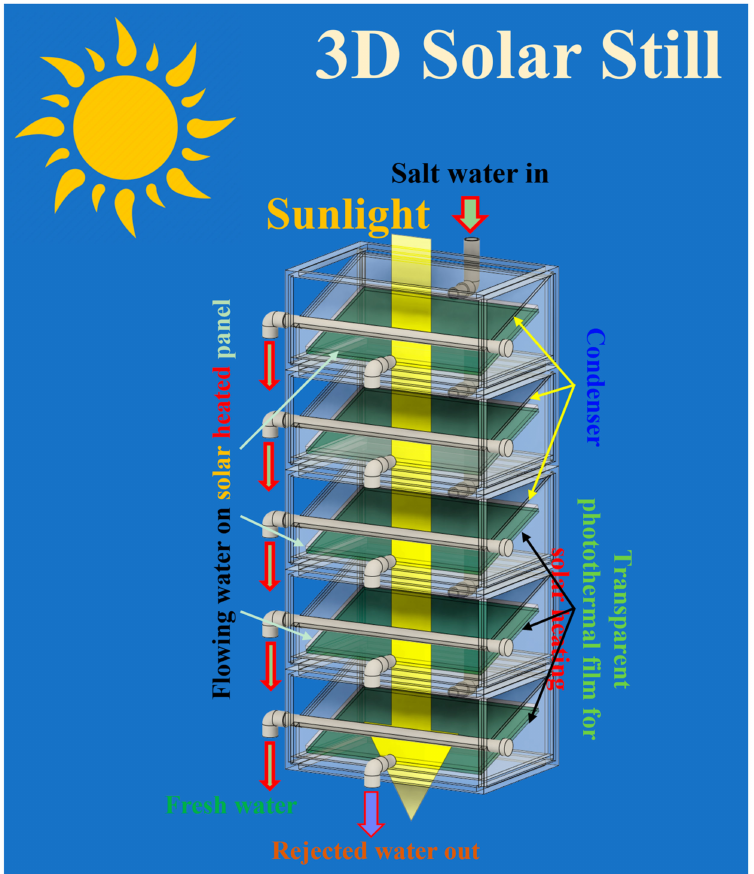
Figure 14. Schematic diagram showing an engineered 3D solar distillation system utilizing the transparent photothermal film in multilayers. In this system, the total solar harvesting/water surface area is significantly enlarged, therefore effectively increasing water yield in